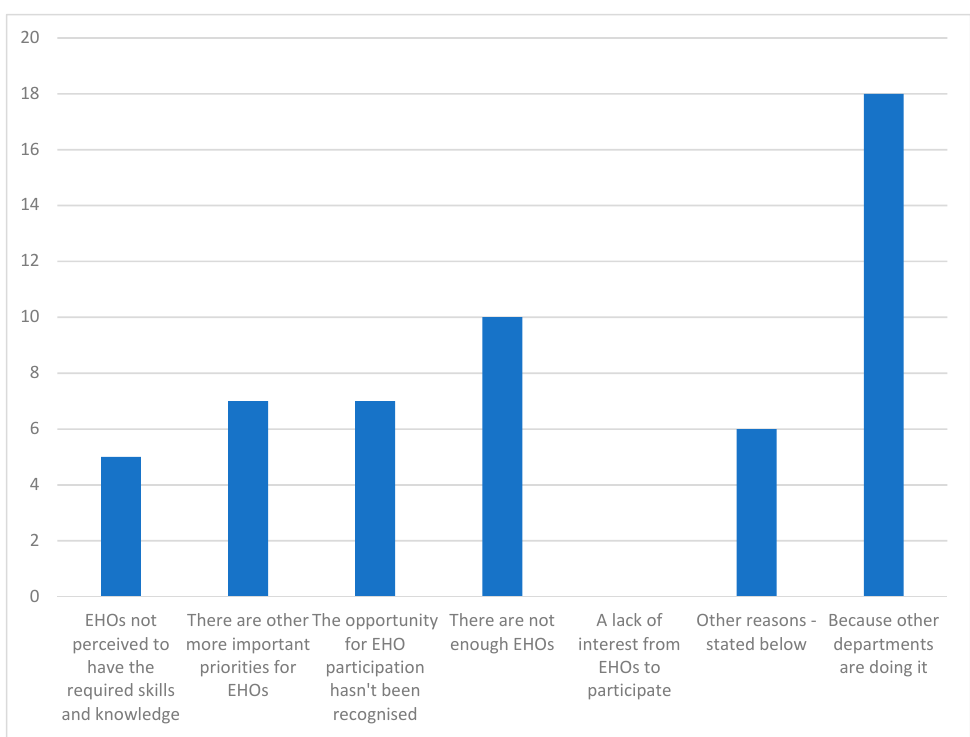
Figure 2. Reasons executives provided as to why local government environmental health officers (EHOs) were not being involved in climate change planning ( n = 28).